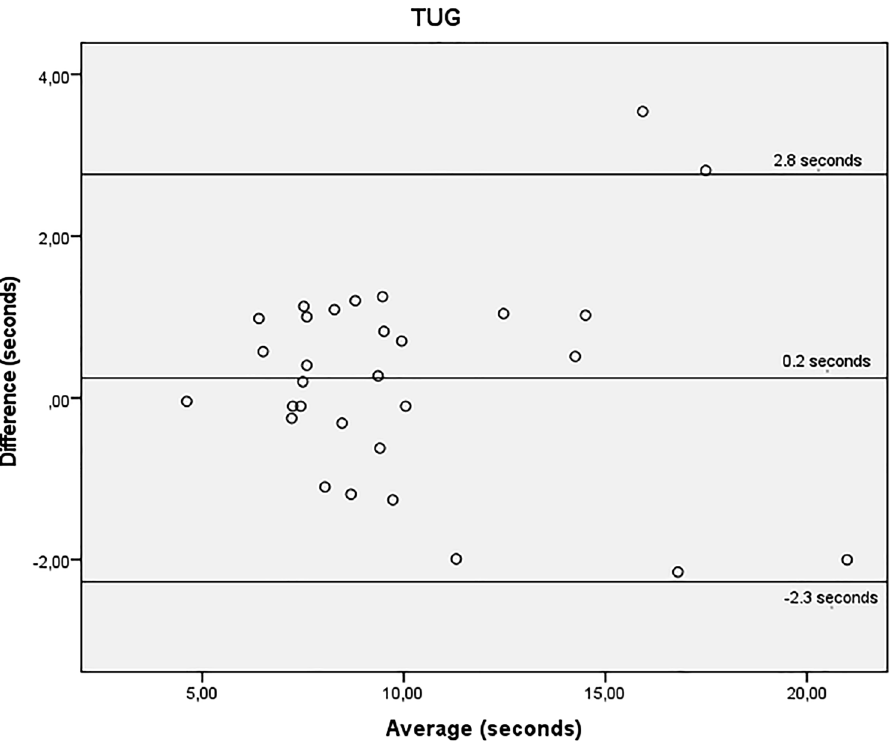
Figure 3. Bland–Altman plots showing agreement for the time required to perform the timed up-and-go test, obtained before the haemodialysis session and on a non-dialysis day by the same rater. Y axis difference between (non-dialysis—before the haemodialysis session) seconds. X axis average (non-dialysis + before the haemodialysis session)/2